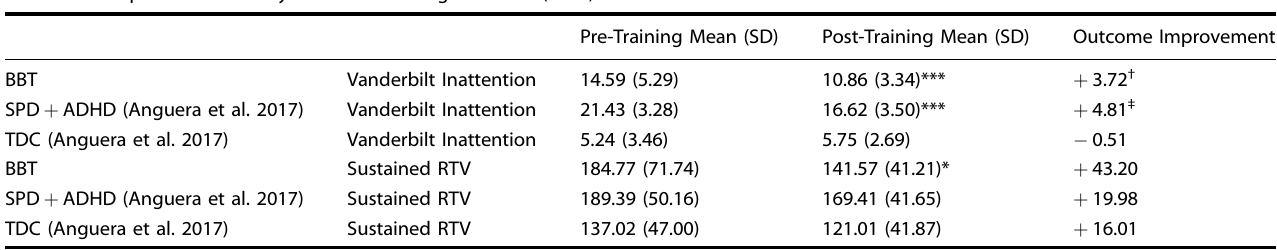
Table 3. Comparison of Primary Outcomes to Anguera et al.